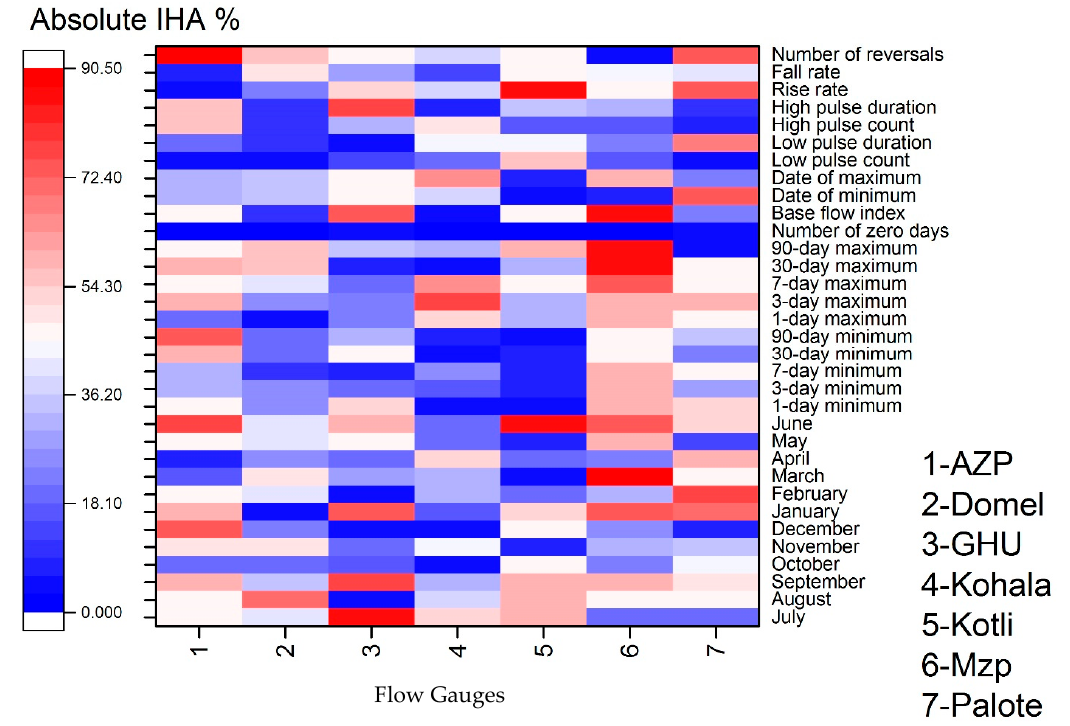
Figure 2. Absolute Hydrological alteration in the Mangla watershed.